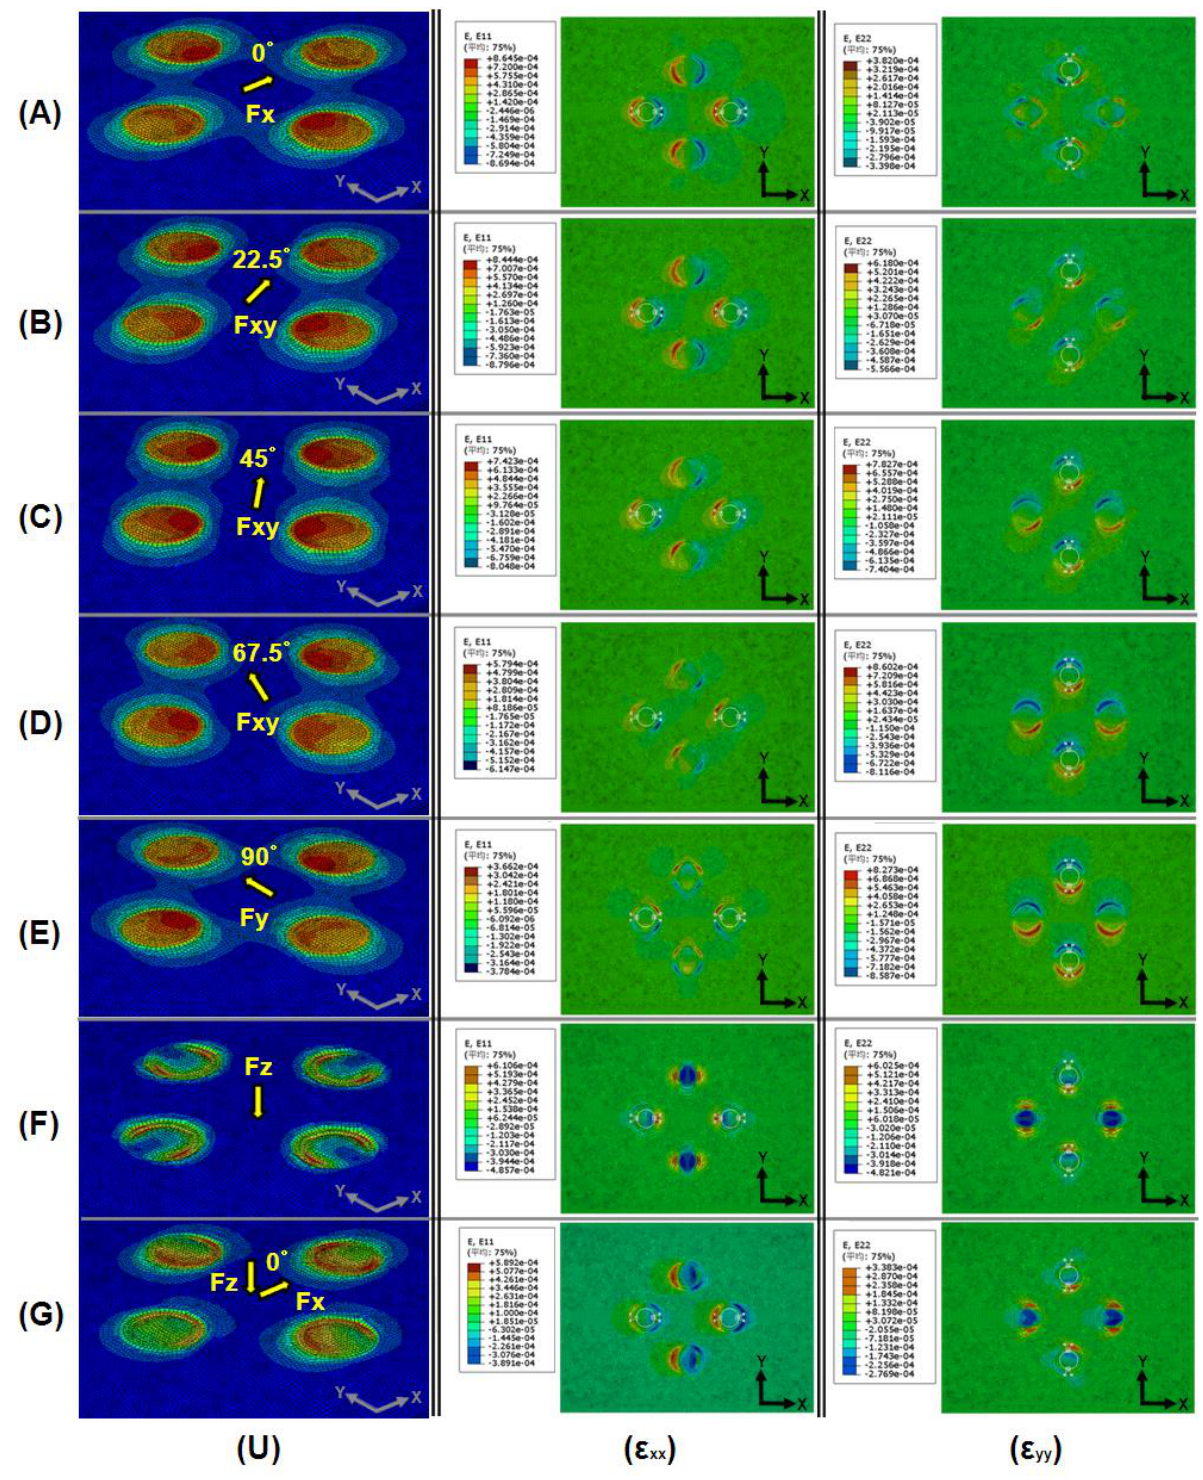
), (ε ) xx yy ), (ε xx yy